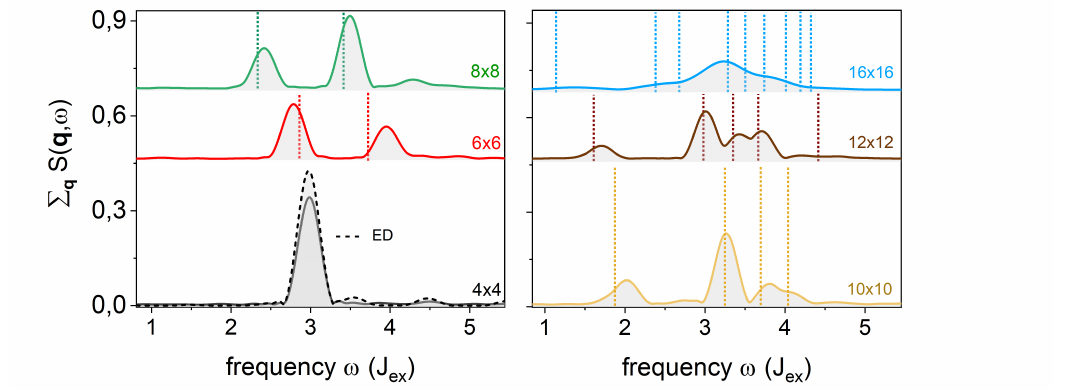
= 0.1 J Figure 4: Integrated structure factor for different system sizes and ∆ J ex ex (solid lines). Data for 4 × 4 are compared with ED (dashed black line) showing excellent agreement in the position of the main peak. Data for larger sizes are com- pared with the frequency peaks of the excited modes obtained with interacting spin wave theory (dotted vertical lines). The Fourier transform to the frequency domain = 10 / J exploits a time window with total time length t for system sizes up to max ex = 5 / J 12 × 12; for 16 × 16, t . The RBM ansatz captures all the modes from RPA max ex and closely resembles their position in the frequency